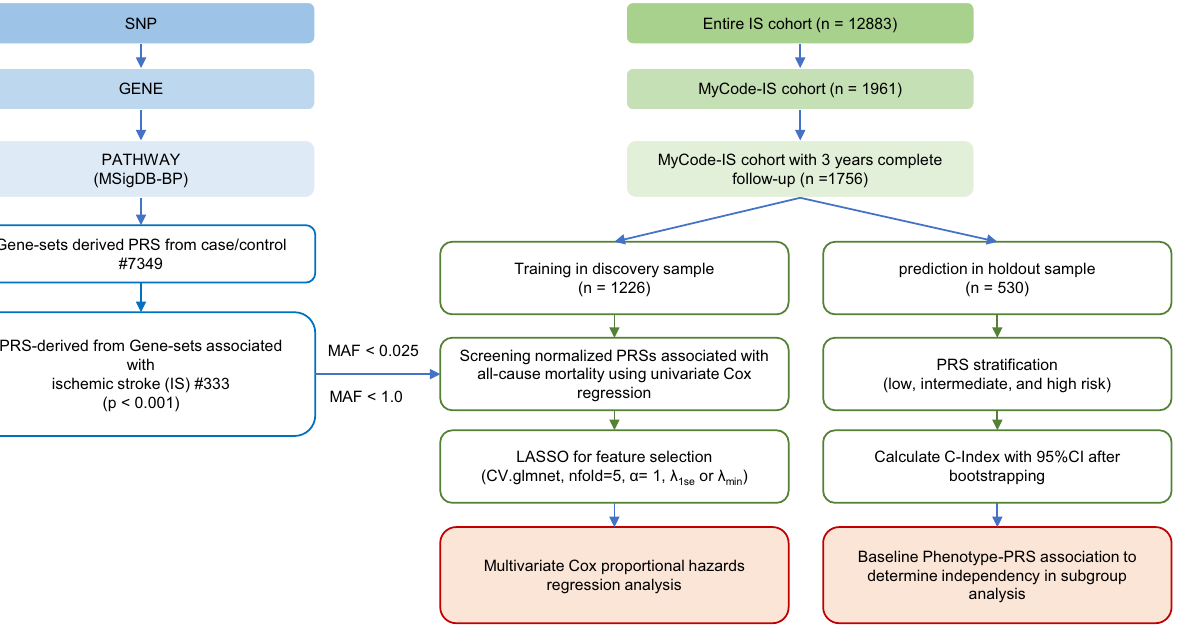
Figure 1. A flow chart for the strategy of the entire analysis. Domain Knowledge-based approach to identify disease-relevant pathway-specific PRSs and further predict all-cause mortality using an integrated multivariate Cox proportional-hazards model with features selected by